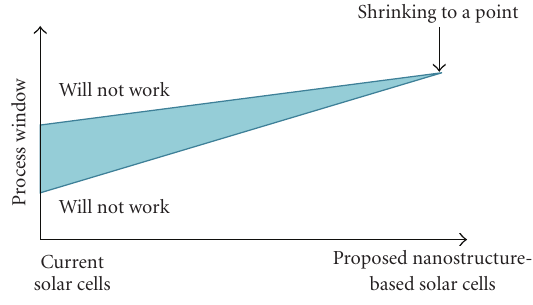
Figure 2: Shrinking process window for ultra-small